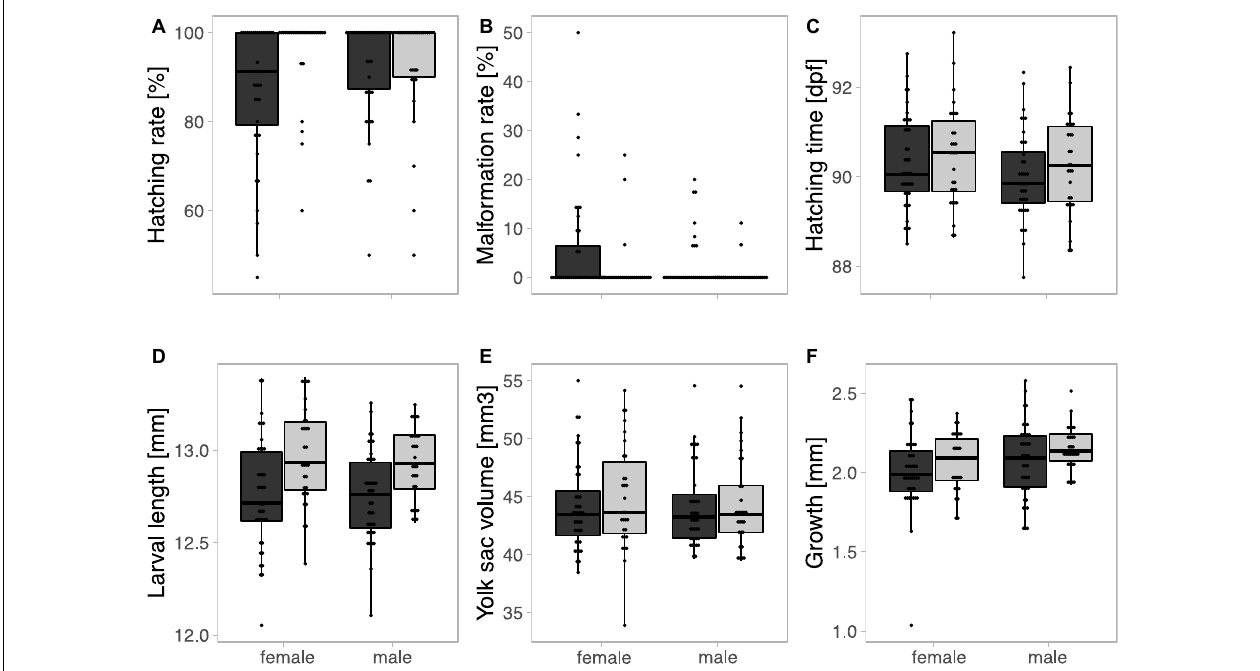
FIGURE 2 | Effects of genetic sex and environment on (A) hatching rate (as measure of embryo survival), (B) rate of malformations among hatchlings, (C) the timing of hatching (dpf = days post-fertilization), (D) larval length at hatching, (E) yolk sac volume at hatching, and (F) increase of larval length during the first 14 days after hatching. Tukey outlier boxplots with quartiles, whiskers, and jittered family means for female and male embryos. Black and gray symbols represent stressful and non-stressful environments, respectively. See Table 2 for statistics.